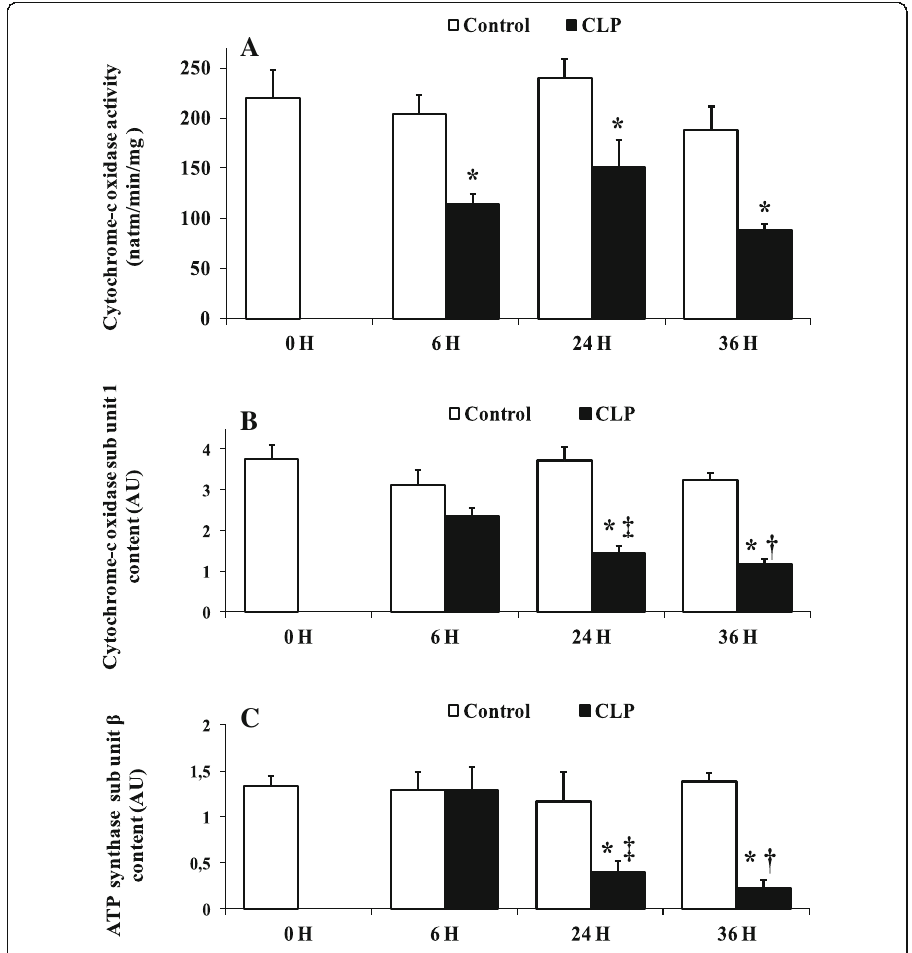
Fig. 3 Cytochrome-c oxidase activity and sub unit 1 content, and ATP synthase sub unit β content. a Liver mitochondrial cytochrome c oxidase maximal activity of controls groups (naïve and sham-operated control) (white bars) and CLP groups (black bars). Data are means ± SEM. * p < 0.05 versus sham-operated and naïve rats from five animals per group determined by surgical procedure and following period (0, 6, 24, 36 h). Western blot analysis of liver mitochondrial cytochrome-c oxidase sub unit 1 ( b ), and ATP synthase sub unit β ( c ) in controls groups (white bars) and CLP groups (black bars). Data are means±SEM. * p <0.05 versus matching sham-operated control rats; ‡ p <0.05 compared 6 h CLP and 24 h CLP; † p <0.05 compared 6 h CLP and 36 h CLP, from five animals per group determined by surgical procedure and following period (6, 24, 36